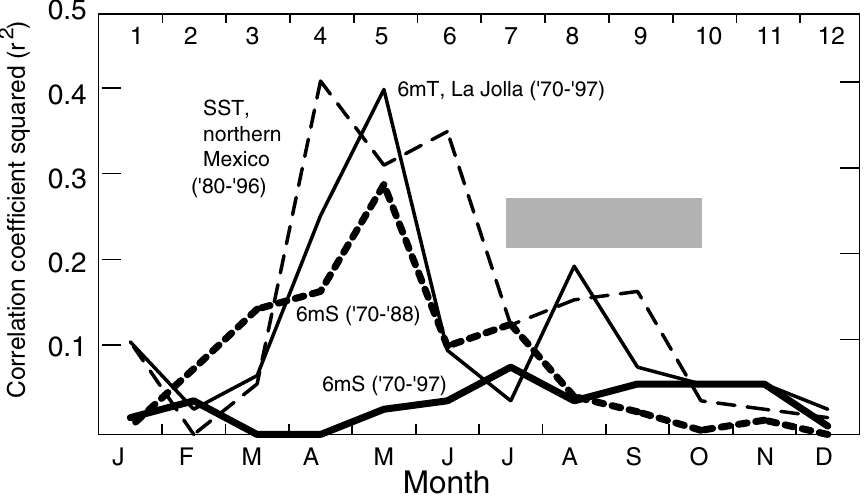
F IG . 7. – Correlation (r 2 ) of temperature and salinity indices with CPFV dolphinfish catch. Positive correlations of annual dolphinfish catch to monthly average sea surface temperature (SST) off northern Mexico (light, broken) and 6 meter temperature (6mT) at the La Jolla shore station (light, solid). The heavy lines show r 2 for negative associations of salinity (bmS) with CPFV catch. Correlation intervals are shown in parentheses (1970-1988, broken and 1970-1997, solid). Period of dolphinfish availability to southern California CPFV anglers is shaded. For r 2 > 0.3, p <